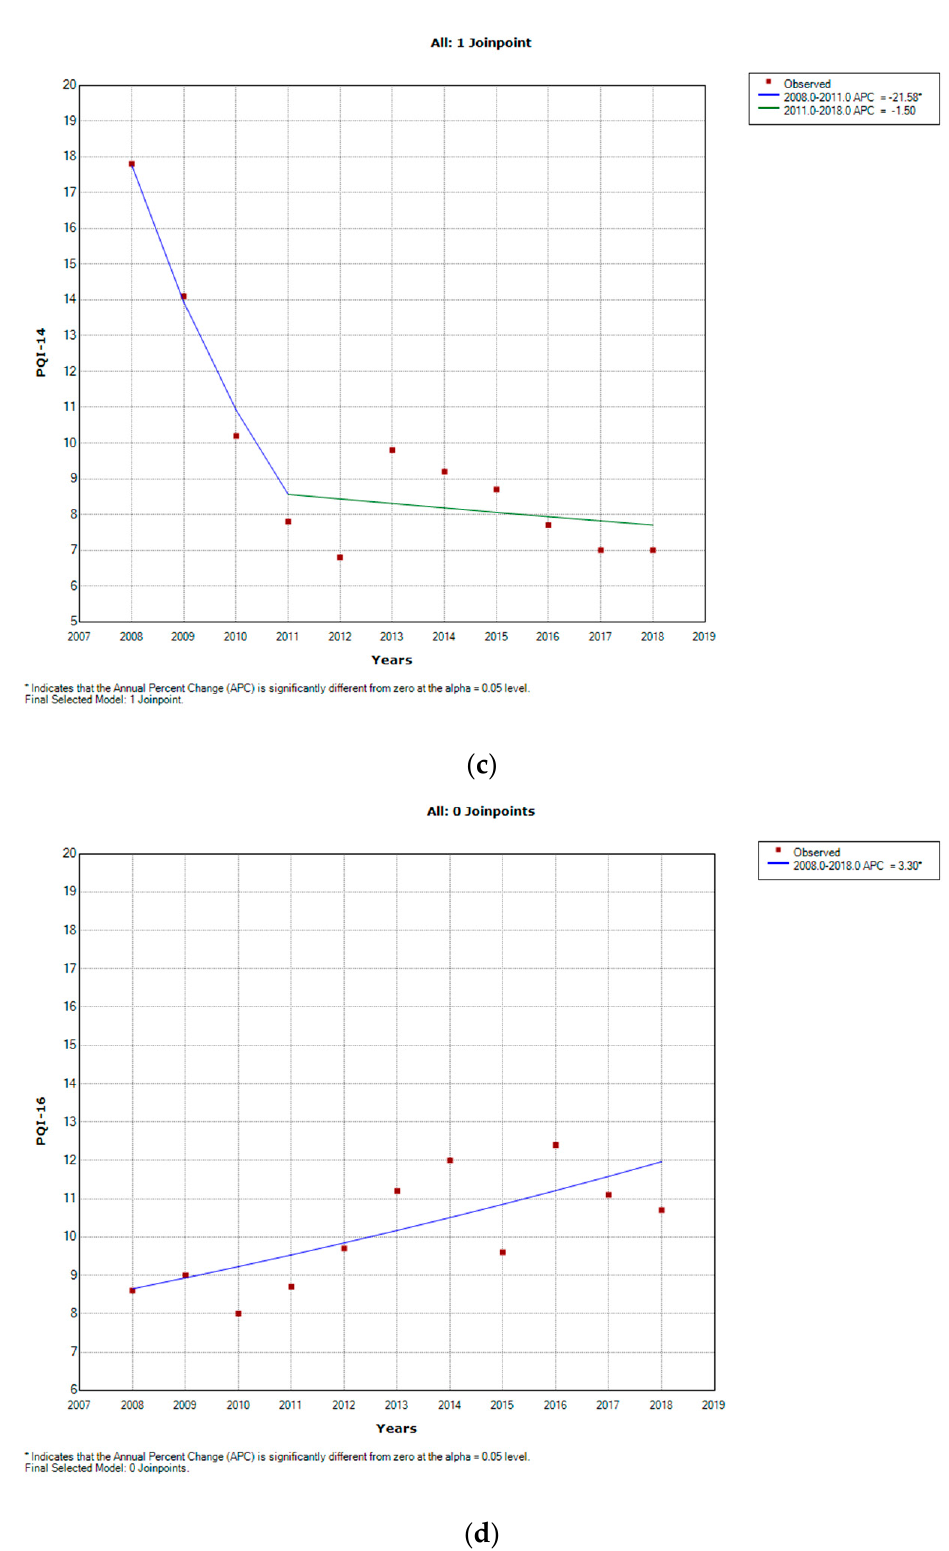
Figure 1. Joinpoint regression analyses reporting annual age and gender standardized rates and average annual percentage change (AAPC) observed for diabetes-related preventable hospitalization from 2008 to 2018. ( a ) PQI-01; ( b ) PQI-03; ( c ) PQI-14; ( d ) PQI-16; * Indicates that the APC is significantly different from zero at the alpha = 0.05 level.